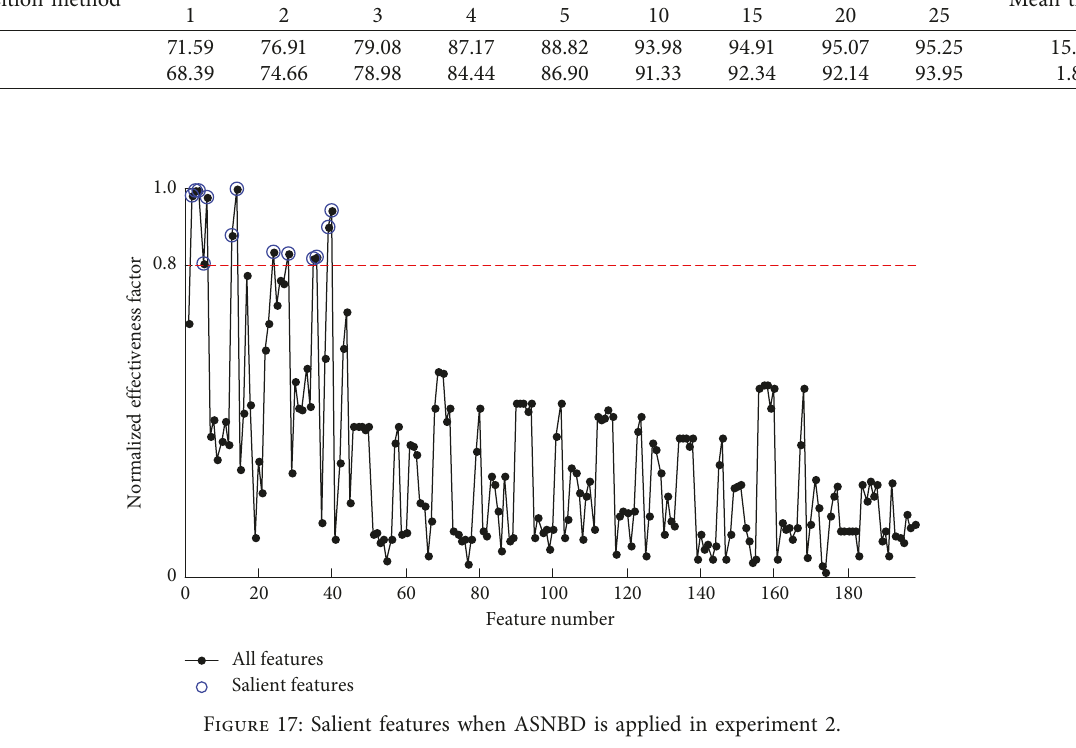
Table 6: Classification accuracy of MMC-CH ( P